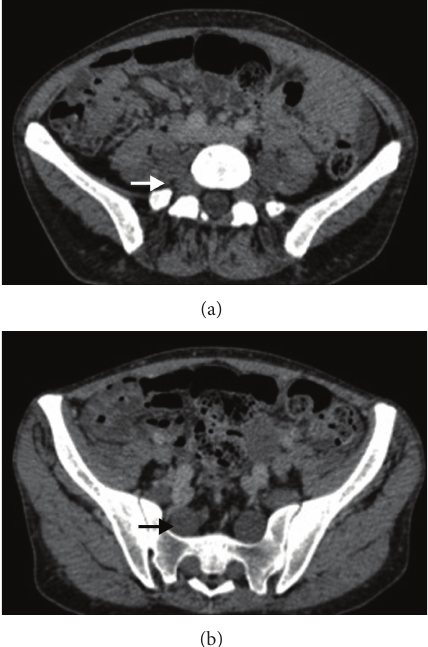
Figure 6: A 34-year-old woman with neurofibromatosis type I. Axial CT show plexiform neurofibromas of lumbar and sacral nerve